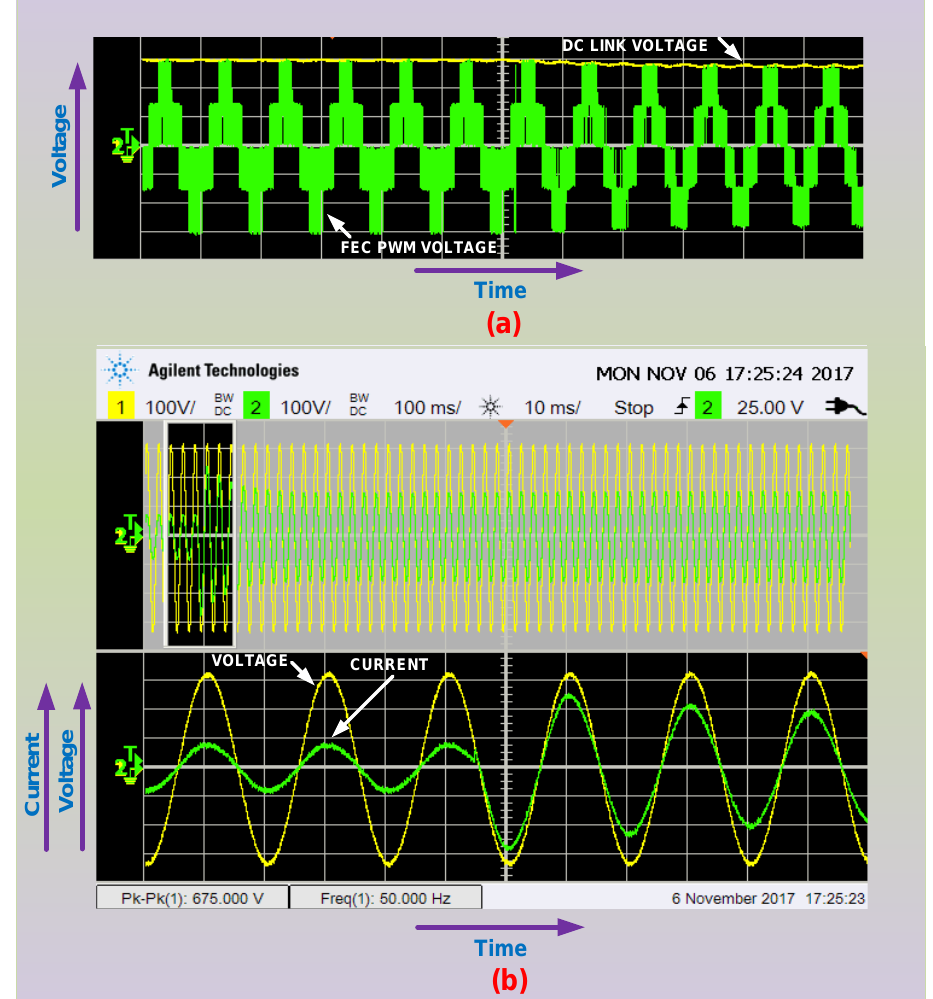
Figure 5. ( a ) Input Voltage and Current Waveforms of T-Type Front-End Converter ( b ) Input Voltage and Current Waveforms of T-Type Front-End Converter during Transition time for a step change in